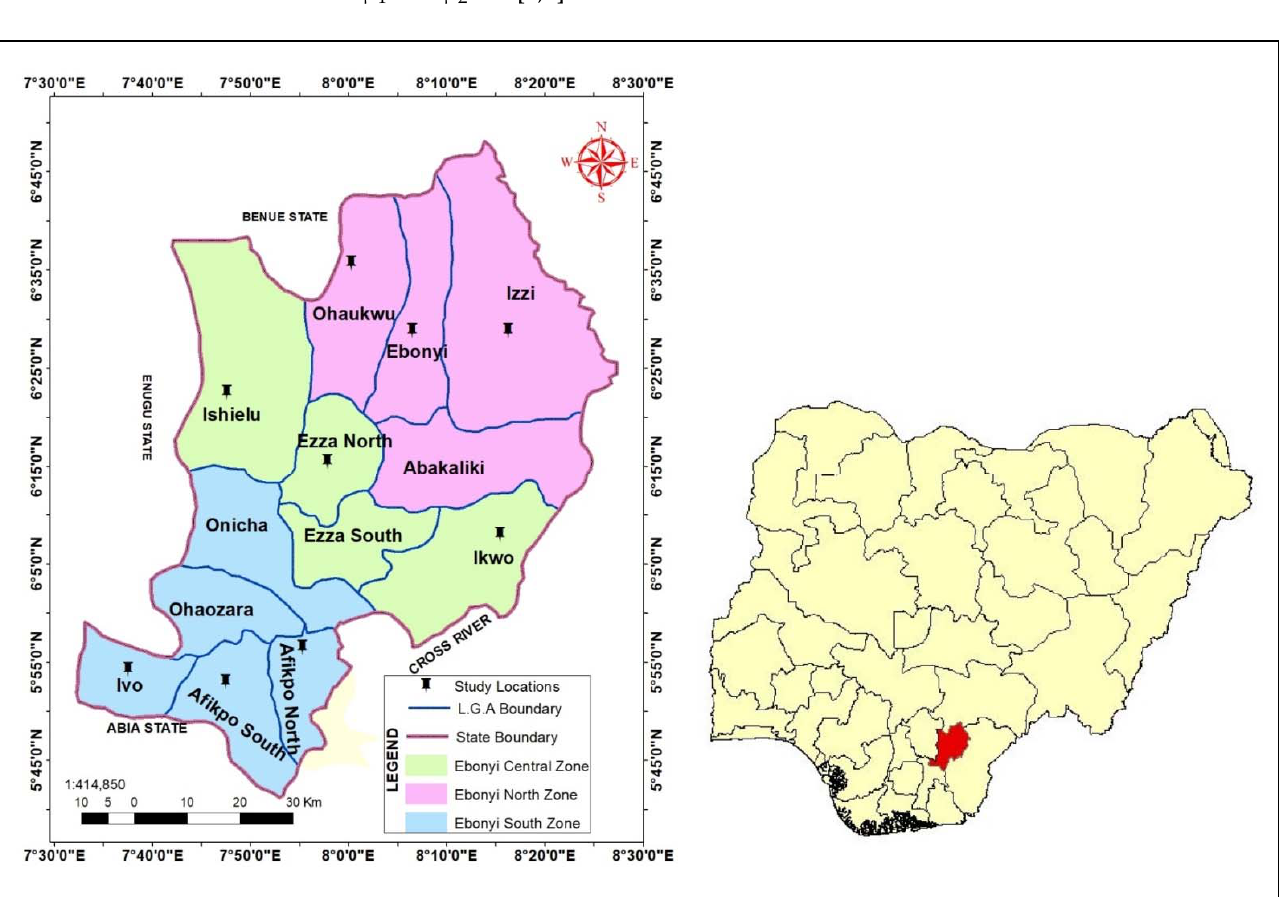
Figure 1. Map of Ebonyi state showing the agricultural zones and local government areas.